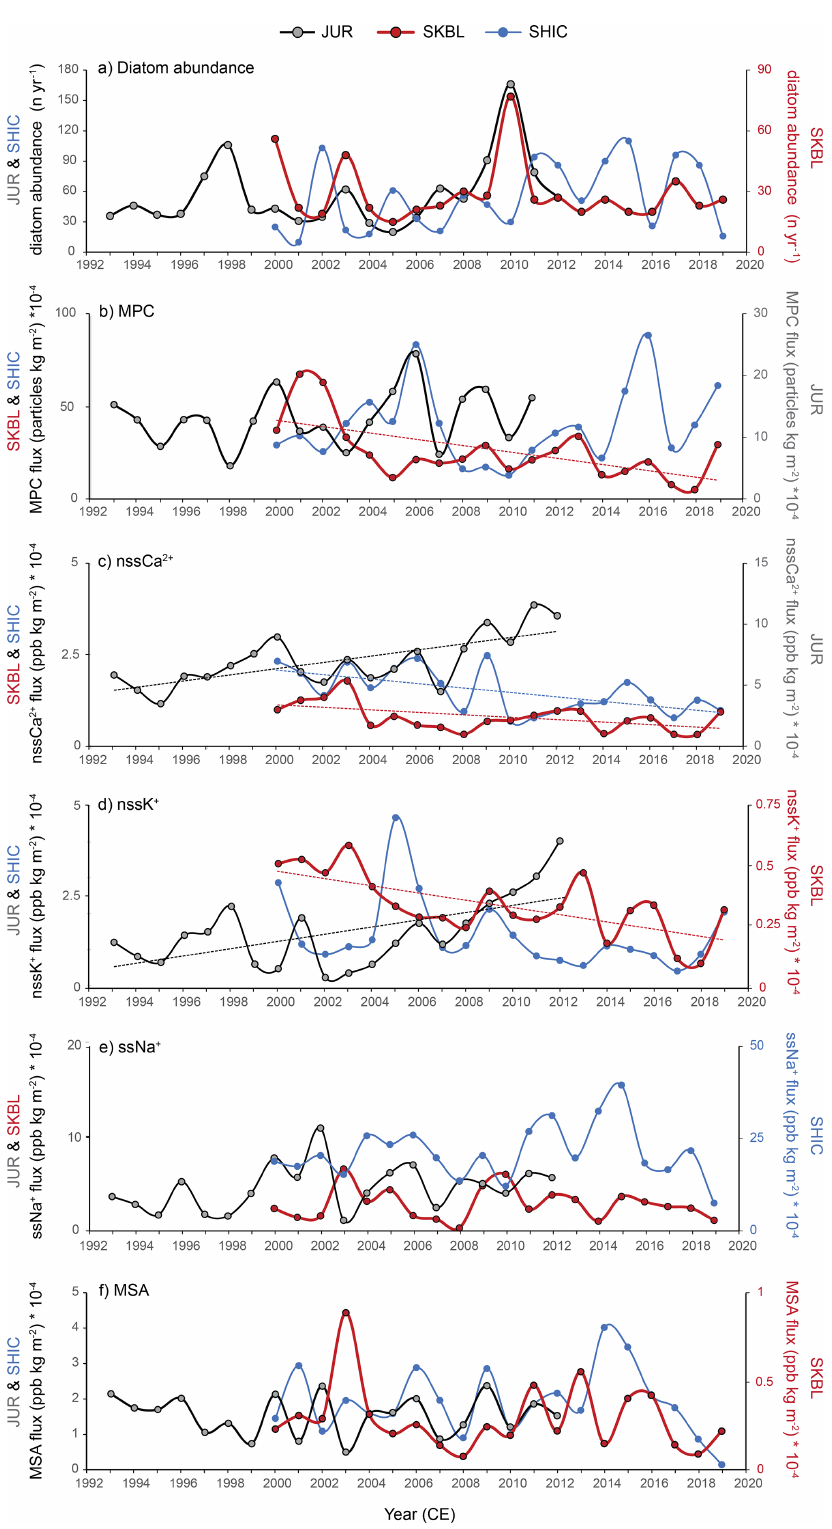
Figure 2. Time series of chemical species fluxes, MPC flux and diatom abundance for each ice core site. Data points represent the an- nual austral winter-to-winter average and were plotted over the correspondent austral summer. Colour-coded dashed lines show statistically significant linear trends ( p < 0 . 05). The MPC flux record from JUR covers the interval 1992–2011CE. Data presented in panel (a) were previously presented by Tetzner et al.